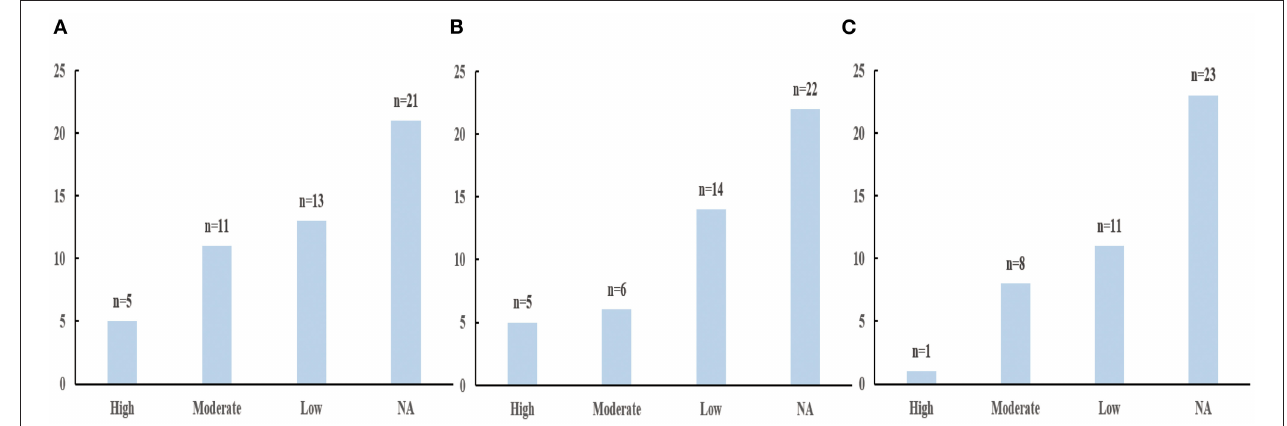
FIGURE 6 | The results of evidecnce assessment. (A) Low alcohol consumption. (B) Moderate alcohol consumption. (C) High alcohol